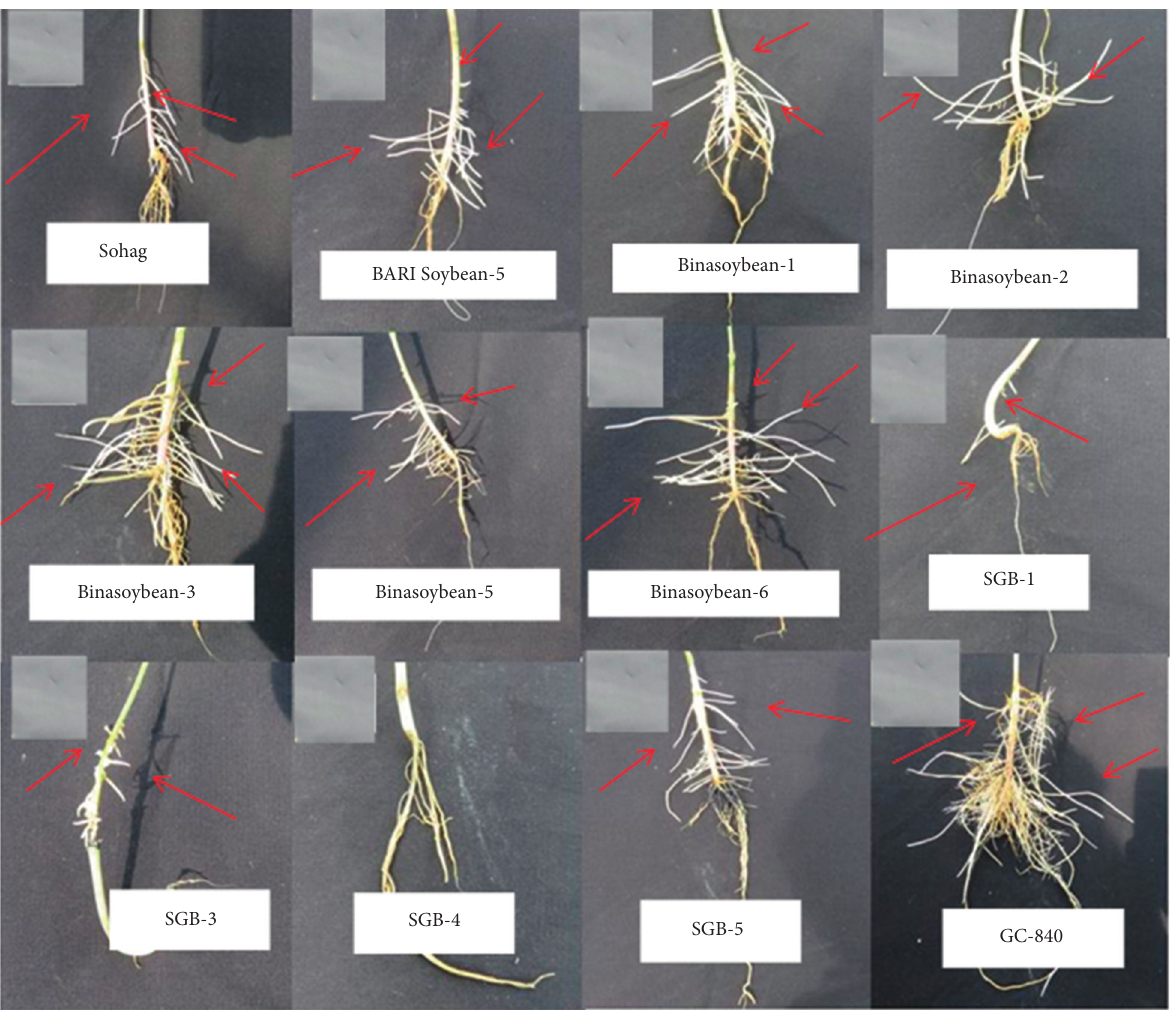
Figure 6: Adventitious root formation of different soybean genotypes under waterlogging condition at 25 DAS. Here, the arrows indicate the adventitious